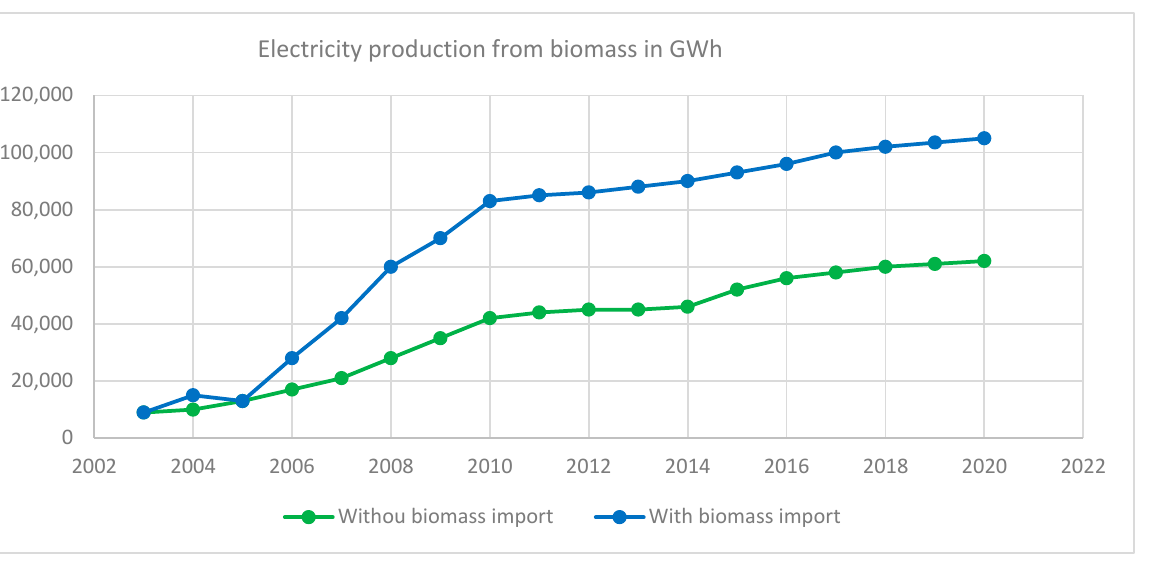
Figure 7. Electricity production from biomass in GWh. Source: Authors’ original compilation based on the Eurostat data